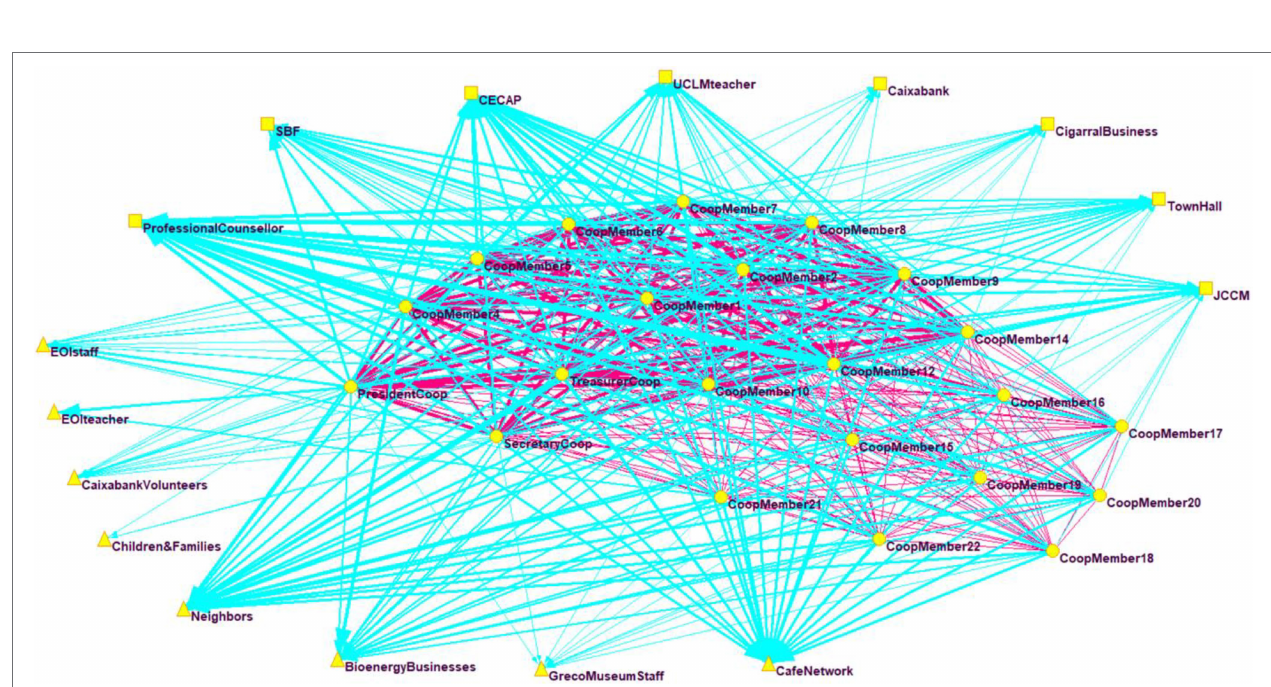
FIGURE 1 | Network of entrepreneurs before company creation. The members/workers of the cooperative (internal stakeholders) are represented by circles, and their relationships are displayed in fuschia, while external stakeholders (organizations that maintained some kind of contact prior to the creation of the company) are represented by squares, and their relationships are drawn in blue.